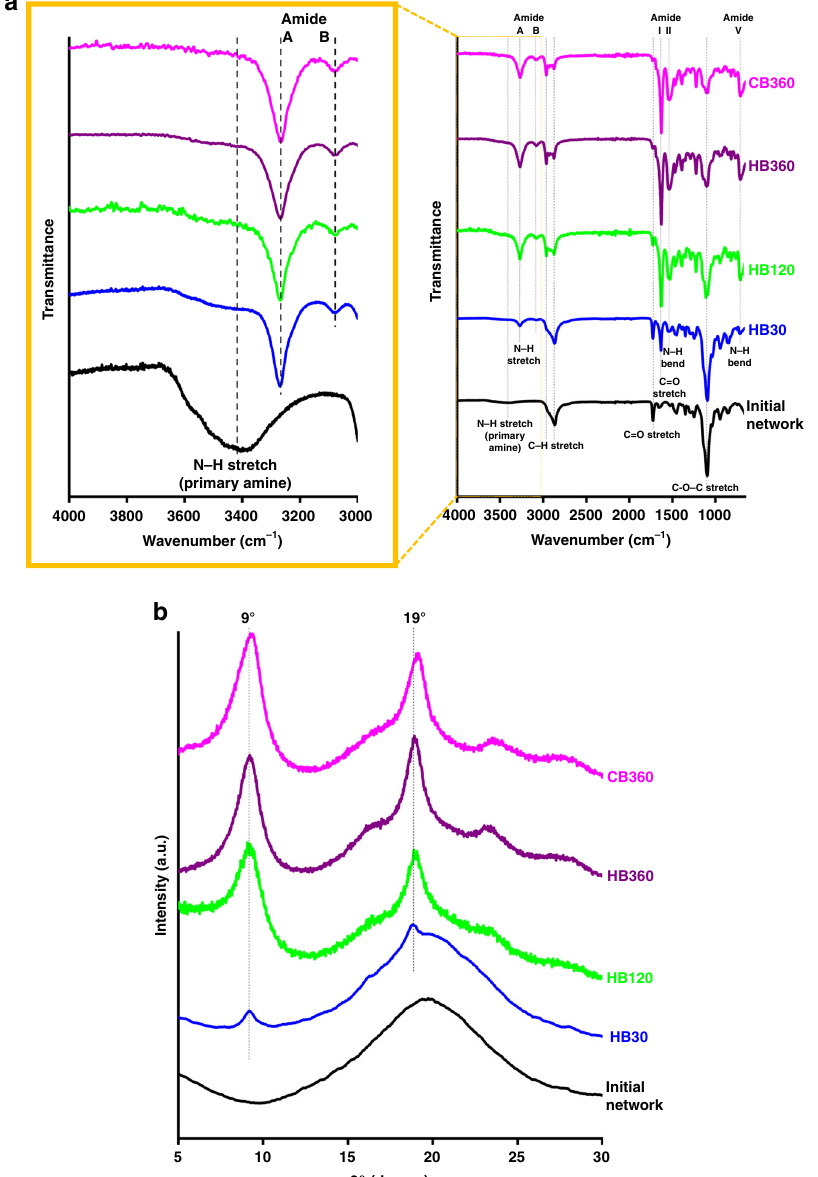
Fig. 5 Structural characterizations of initial and β -sheets-incorporated networks. Networks obtained using different Val NCA monomer concentrations (HB30, HB60, HB360, CB360) indicated as the suf fi x of each legend. a ATR-FTIR with a focus on the spectrum between the 3000 cm − 1 and 4000 cm − 1 ; b XRD